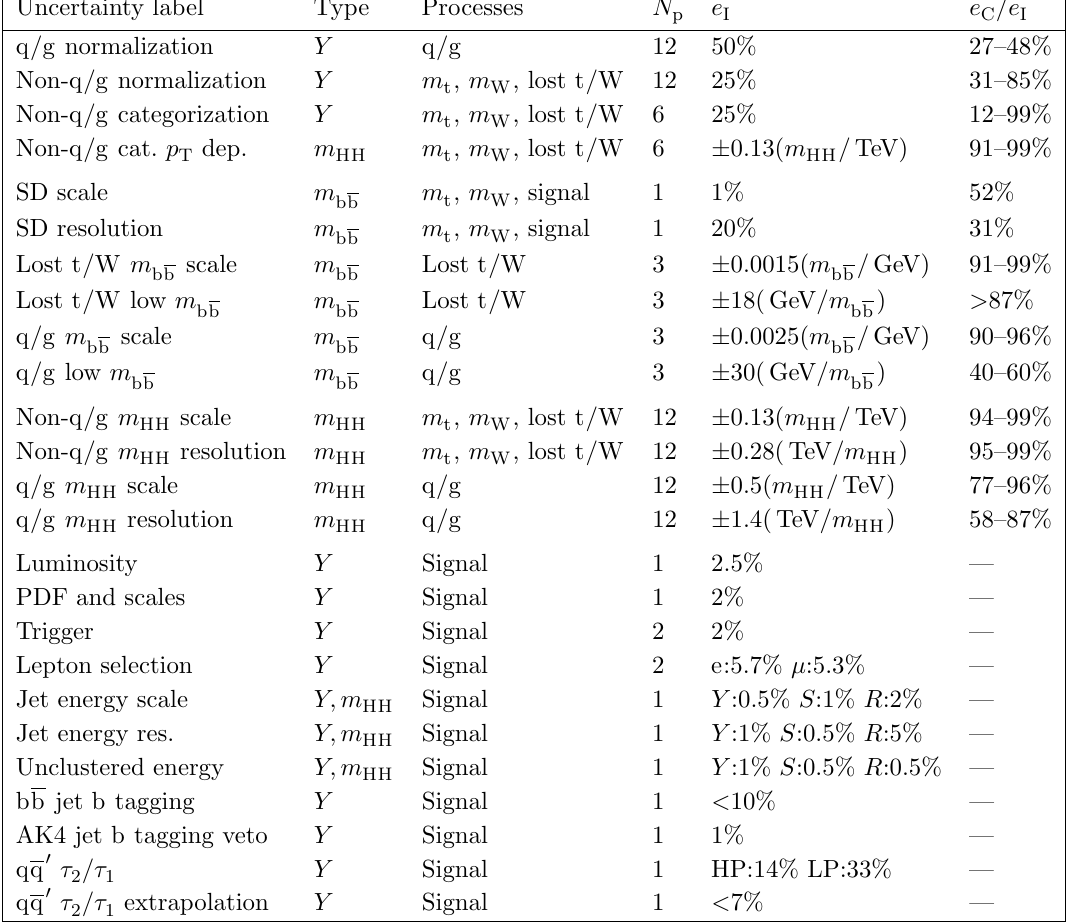
Table 3 . The systematic uncertainties included in the maximum likelihood (cid:12)t and how they are applied to each process model. The \type" indicates if the uncertainty a(cid:11)ects process yield Y or the shape of the m or m distributions. Some uncertainties are applied to multiple event categories HH bb with independent nuisance parameters. The number of such parameters, N size, e , and the ratios of the constrained size to the initial size, e I obtained by (cid:12)tting a model containing only background processes to the data. Uncertainty sizes that vary by event category are listed with category labels. The labels Y , S , and R denote how a single uncertainty a(cid:11)ects yield, scale, and resolution,